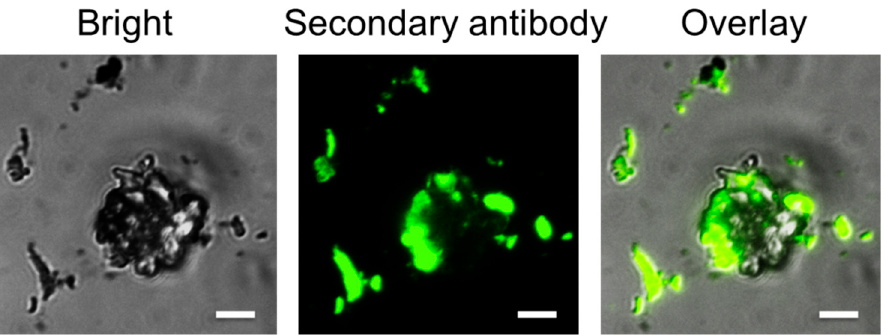
Figure 5. Immunofluorescence of AP3-AuNCs-anti-PDL1. (Scale bar = 1 μ m).